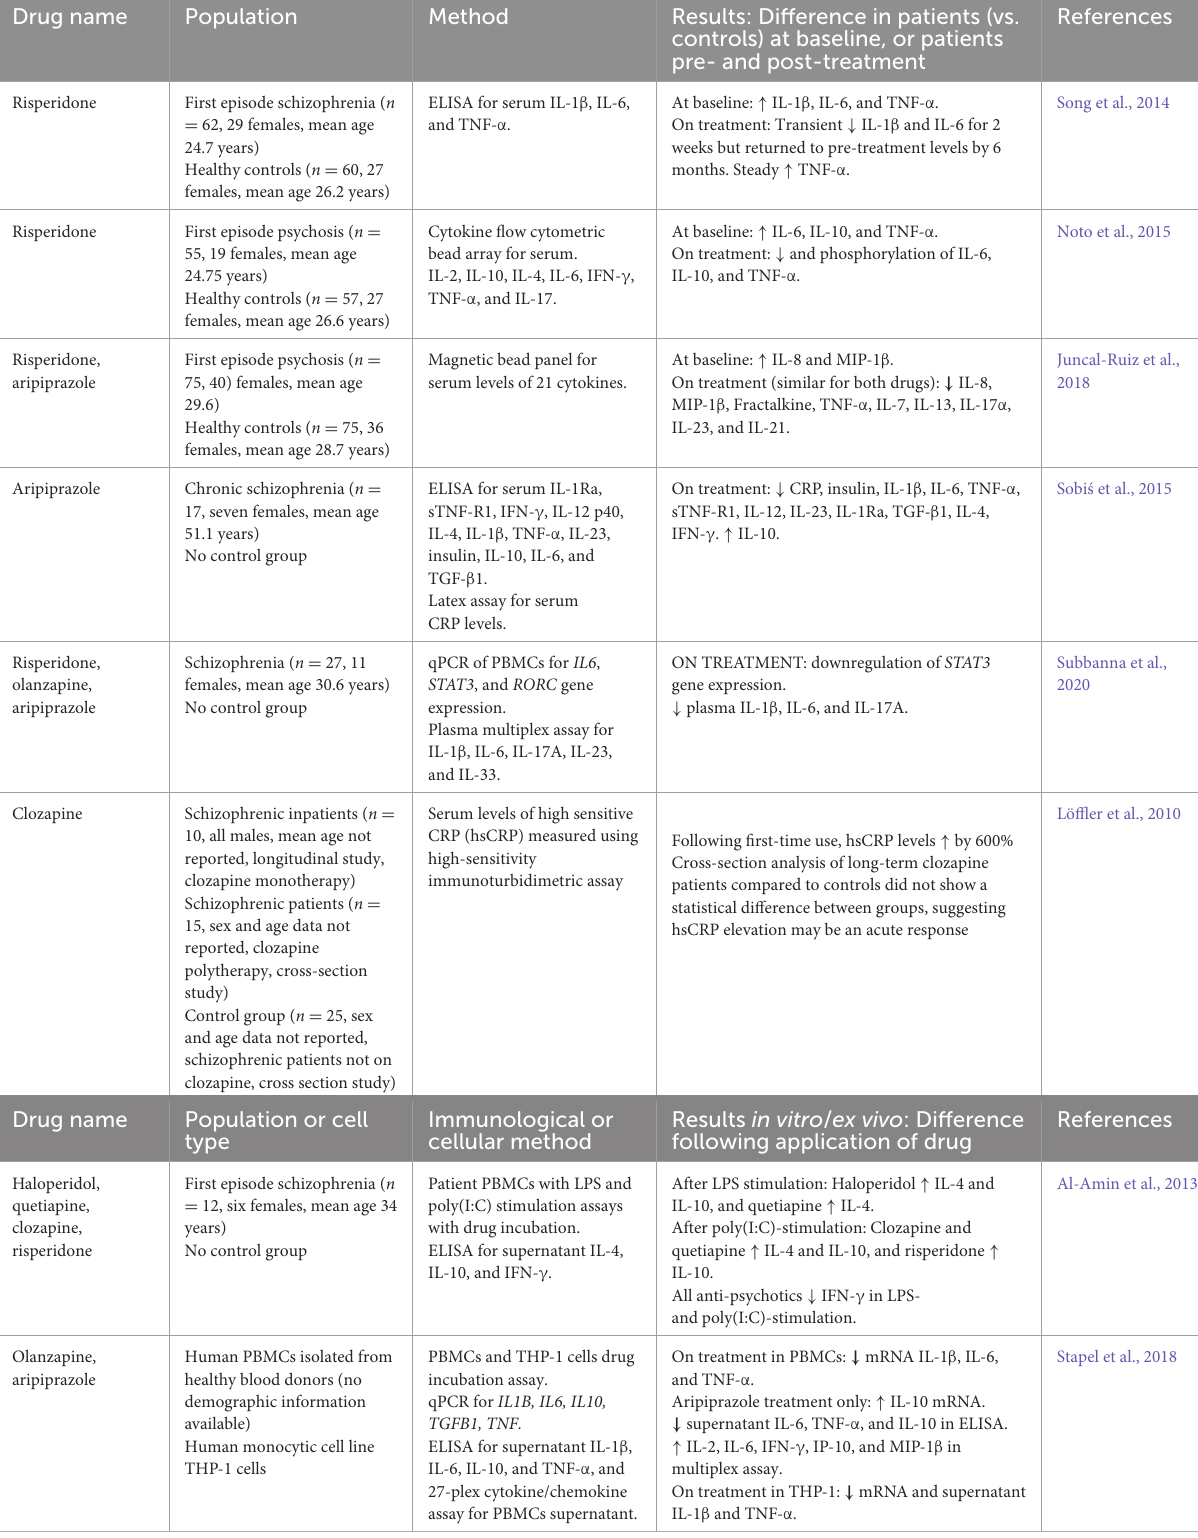
TABLE 3 Anti-inflammatory effects of anti-psychotics in human studies and in studies using in vitro or ex vivo human cells in culture or stimulation assays. Drug